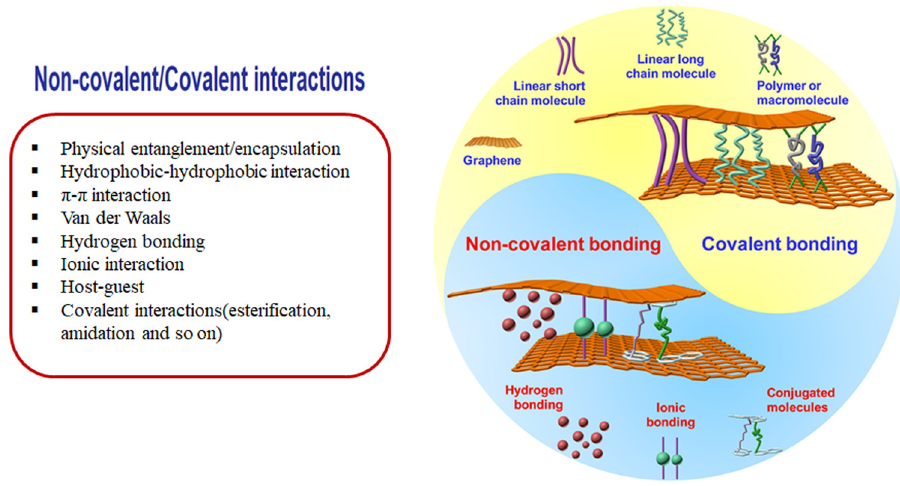
Figure 2: Common enabling interactions between graphene - based materials and biopolymers ( reproduced with permission from refs. [ 9,10 ]) .